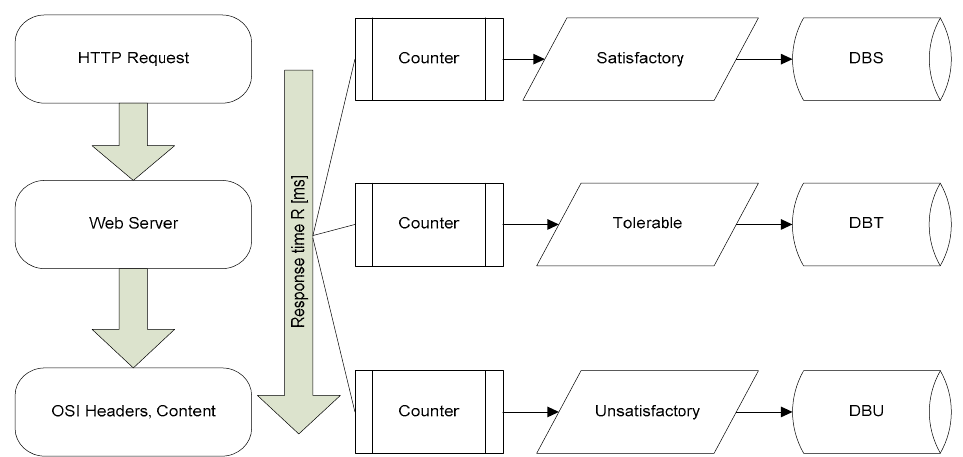
Figure 1. Process for determining Apdex Index. DBS: database with number of satisfactory response times; DBT: database with number of response times within tolerable limits; DBU: database with number of unsatisfactory response times.